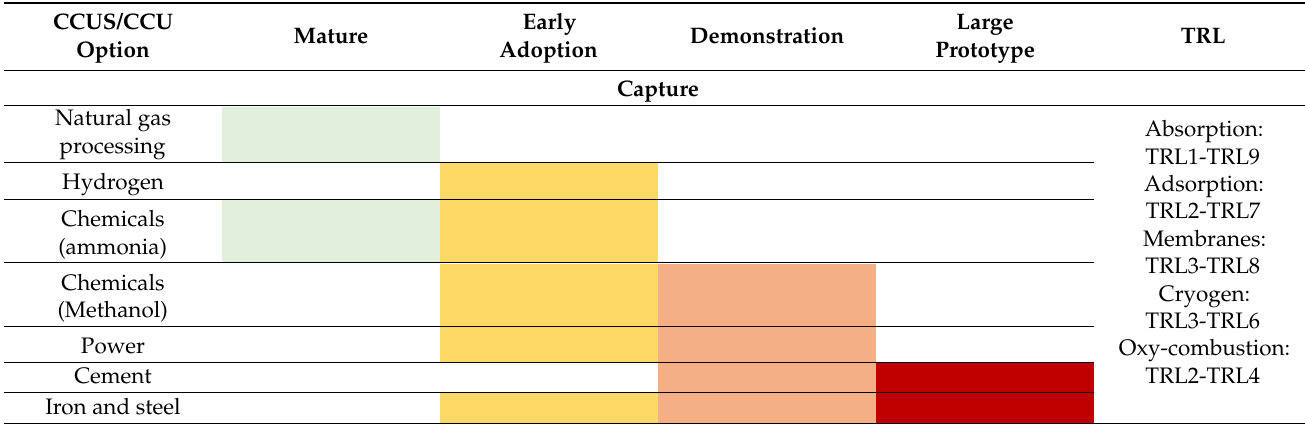
Table 3. Technology readiness level (TRL) of various CCUS/CCU options*. Based on